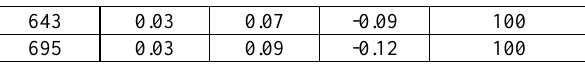
Table 1. Statistics of the effects of a Gaussian (zero mean) distribution of attitude errors in terms of 3D coordinates variation.